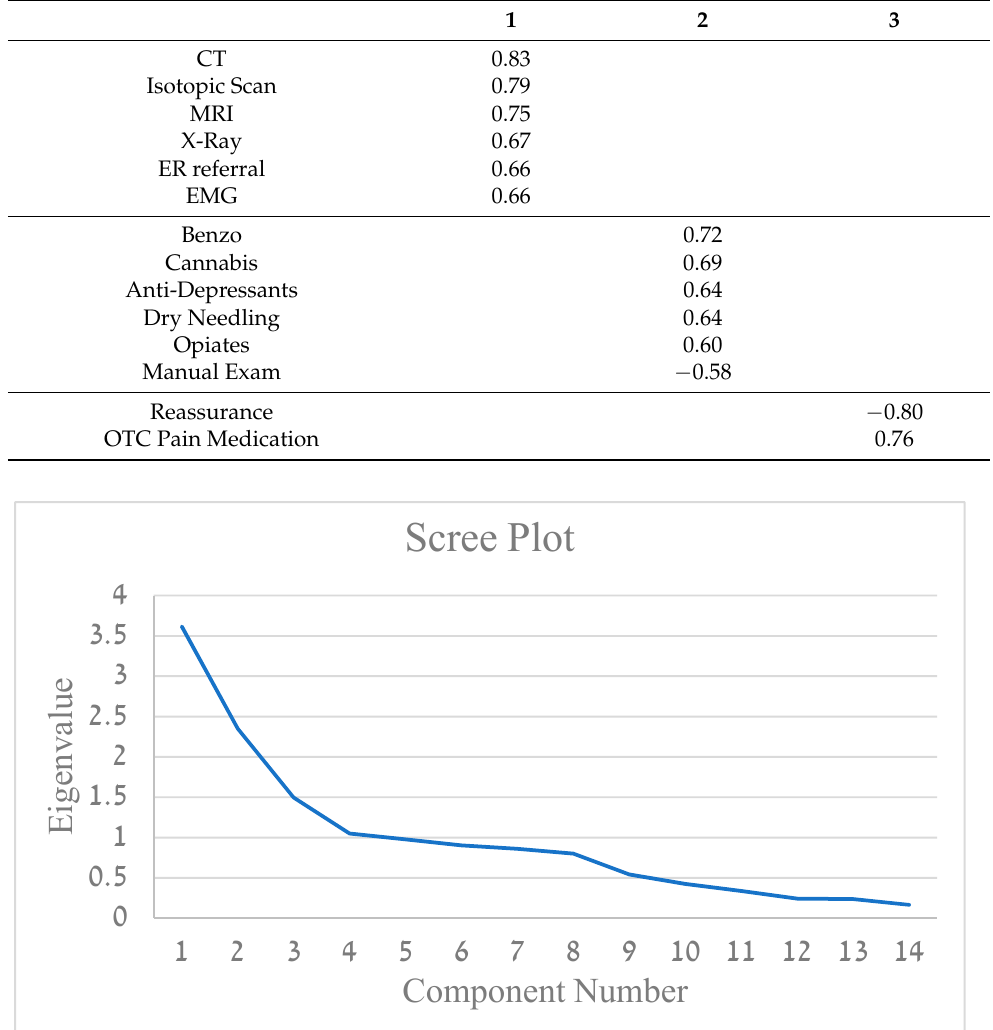
Table 2. Pre-workshop factor loading and communalities for varimax rotated solution for 14 questions (N = 40).